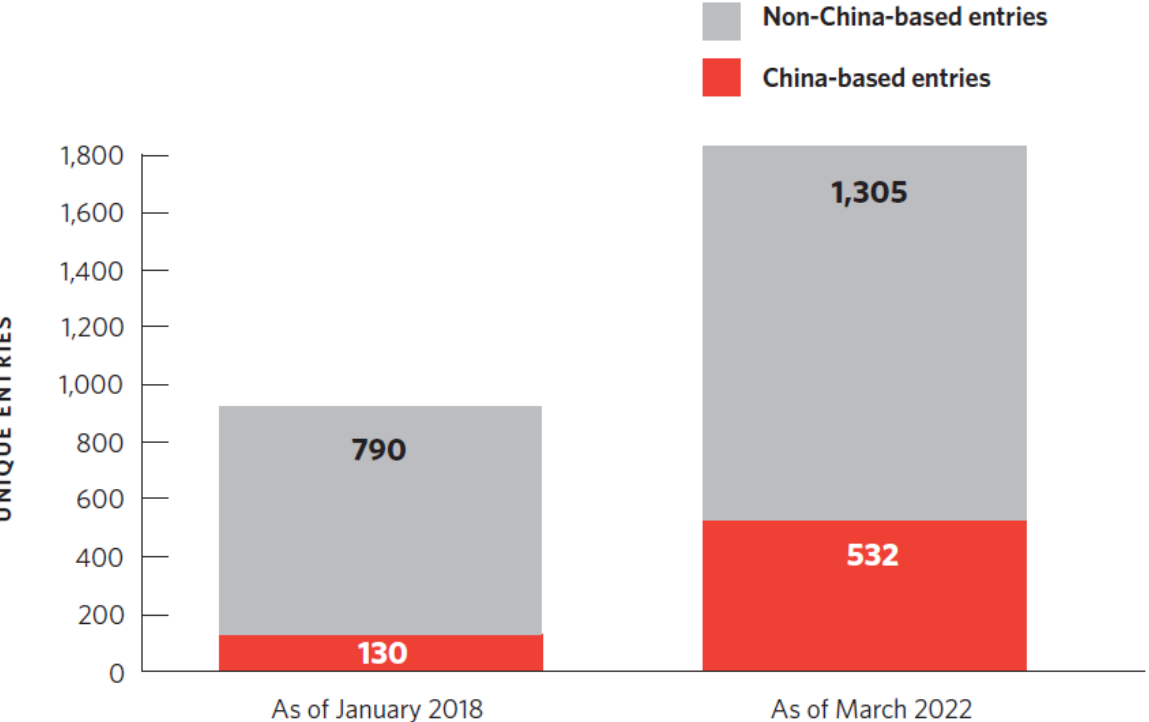
Figure 6. The entity list is increasingly focused on China. Source: US–CHINA TECHNOLOGICAL “DECOUPLING” A STRATEGY AND POLICY FRAMEWORK (2022).